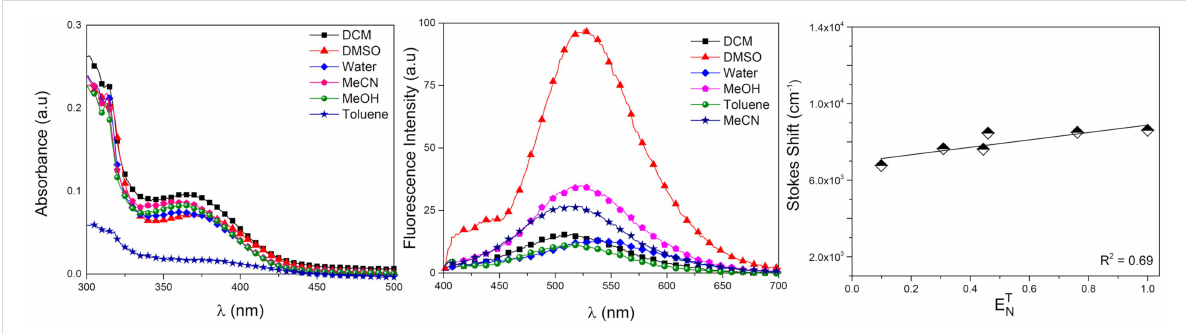
ICT proposition and the calculated linear correlation from the plots [45] corroborated this proposition. The photostability of the new compound was measured in aqueous media as a preclude of the bioimaging experiments and proved to be stable under constant light irradiation for more than 4 hours (see Figure S4 in Supporting Information File 1).